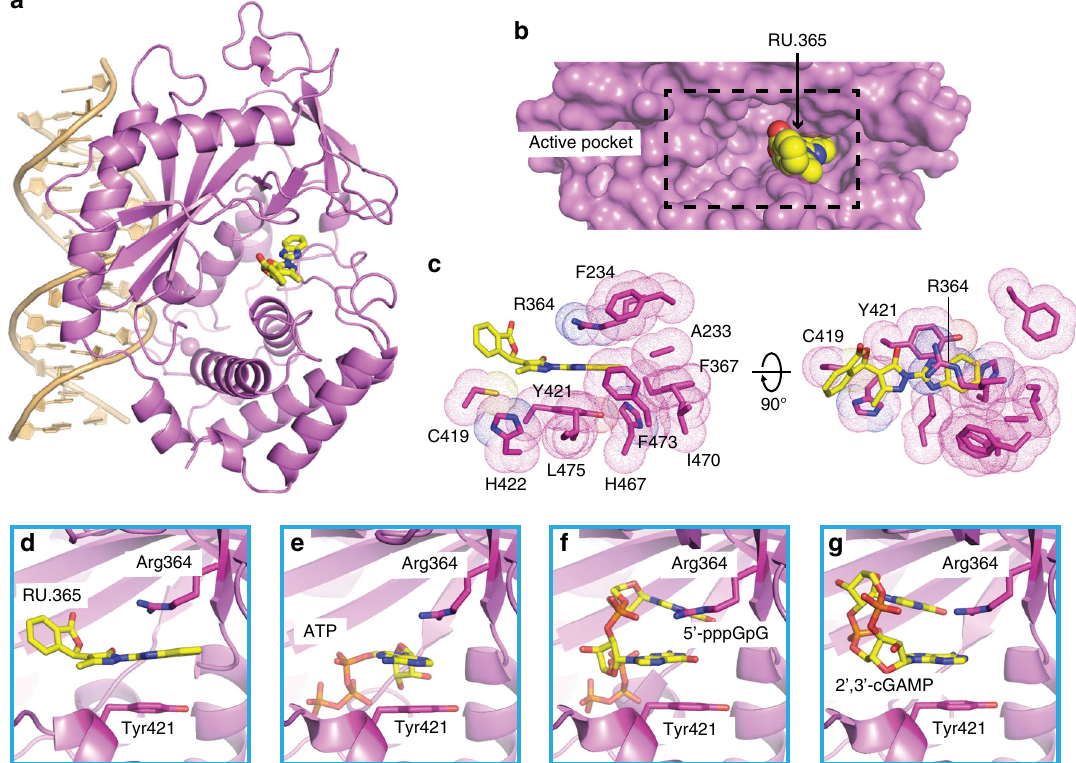
Fig. 2 Ternary crystal structure of cGAS with dsDNA and RU.365. a Overall structure of the cGAS-dDNA-RU.365 complex, with cGAS in violet , dsDNA in light orange , and ligand in yellow . RU.365 is shown in stick representation. b Close-up of the cGAS-binding pocket (shown in surface representation and violet ) and bound RU.365 (show in space- fi lling representation and yellow ). The black dashed box indicates the entire binding pocket of cGAS. c The amino acids (shown in dots and stick , in violet ) surrounding the bound RU.365 (shown in stick , in yellow ). d – g The conserved stacking interaction mediated by Arg364 and Tyr421 with the bound RU.365 ( d ), ATP ( e ), 5 ′ -pppGpG ( f ), and 2 ′ ,3 ′ -cGAMP ( g ). The bound ligands and these two residues are shown in stick